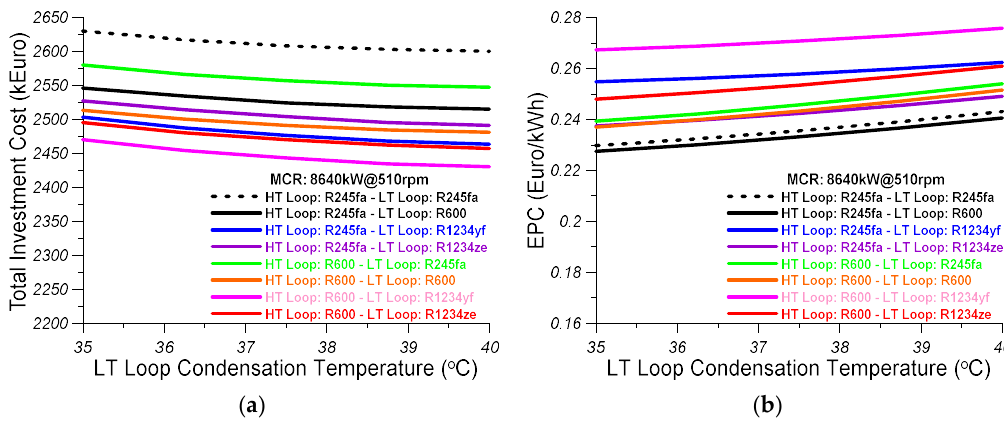
Figure 16. (a) Effect of the condensation temperature of the LT loop on the total investment cost of the regenerative dual-loop ORC; (b) Effect of the condensation temperature of the LT loop on the electricity production cost (EPC) of the regenerative dual-loop ORC. Results are given for all the pairs of organic mediums that are examined in the present study.